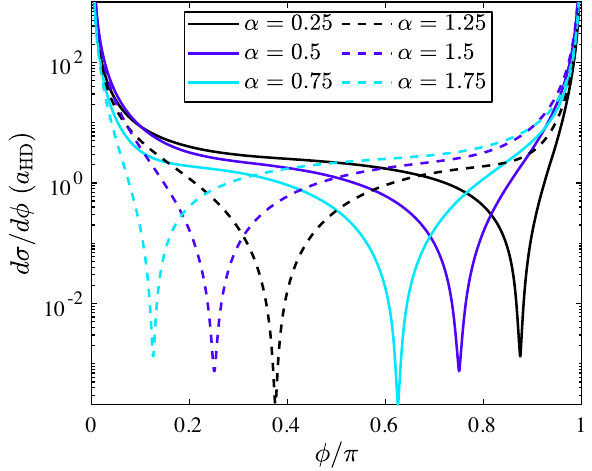
FIG. 5. Differential scattering cross section d σ =d ϕ in units of the hard-core radius a as a function of the scattering angle ϕ for HD a hard-disk interaction potential V between indistinguishable ii 1 , and different impurities, a relative incident momentum ka HD ¼ values of the statistical parameter α , defined as α ¼ ν for bosons and α ¼ 1 þ ν for fermions. Solid (dashed) lines correspond to bosonic (fermionic) impurities inside a FQH bath of filling fraction 0 < ν < 1